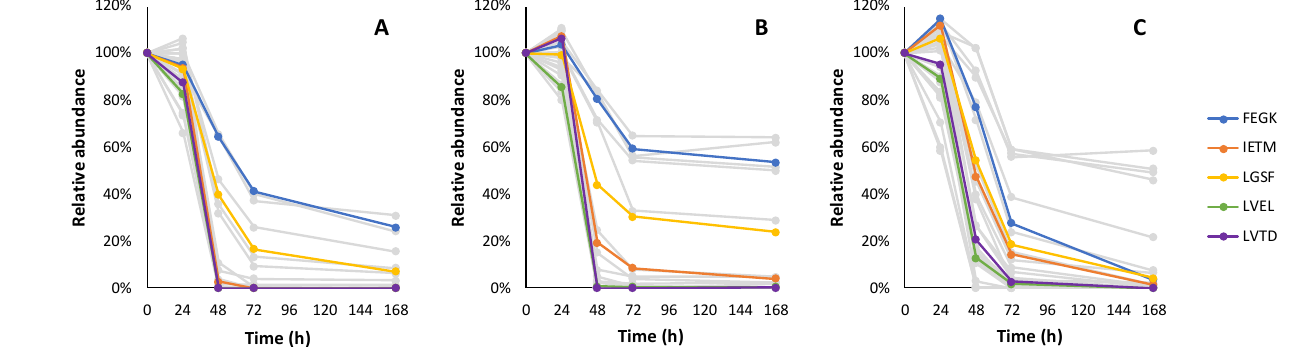
Figure 5. The relative consumption trends of 31 tetrapeptides in fermentation with Lalvin ICV Opale 2.0™ ( A ), Lalvin Persy™ ( B ) and Lalvin QA23™ ( C ) of the modified synthetic must with added BSA hydrolysate as the peptide source. The five tetrapeptide candidates with the highest abundance are shown in colour. Other tetrapeptide candidate sequences and their observed relative consumption trends are shown in Table A6.